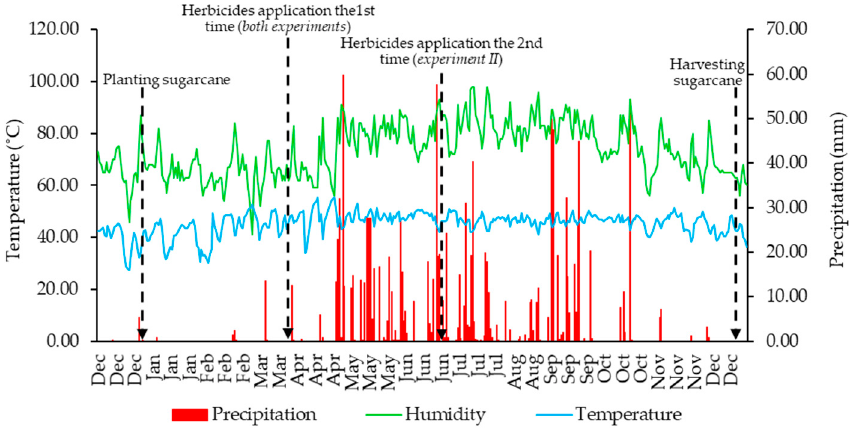
Figure 1. Experiment duration and weather information (2017–2018).